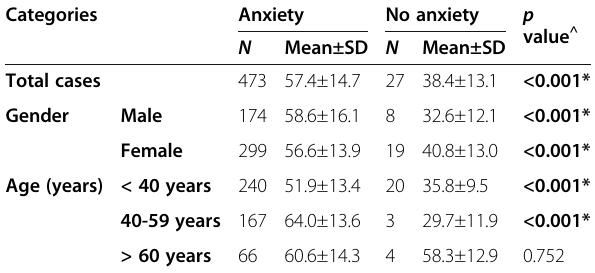
^Independent t test *